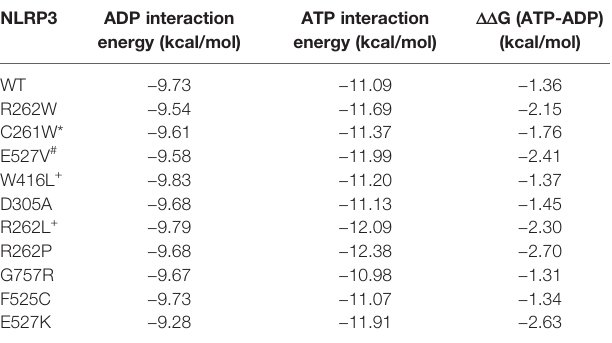
TABLE 3 | ADP, ATP, and ddG Energies for NLRP3 Mutants. NLRP3 ADP interaction energy